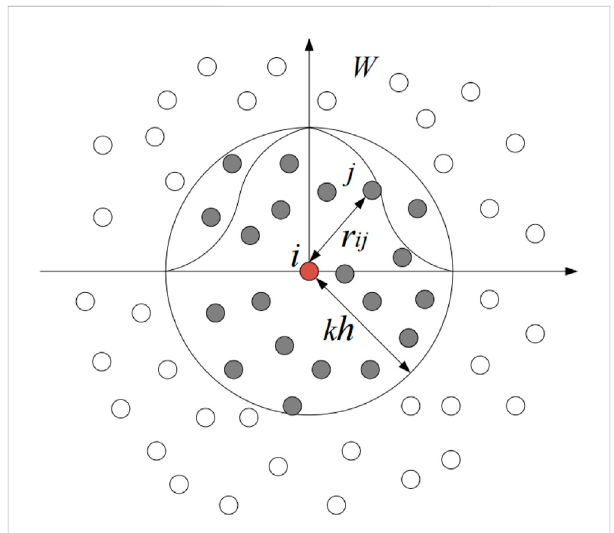
FIGURE 1 Interpolation principle of the smoothed particle hydrodynamics method, including kernel approximation and particle